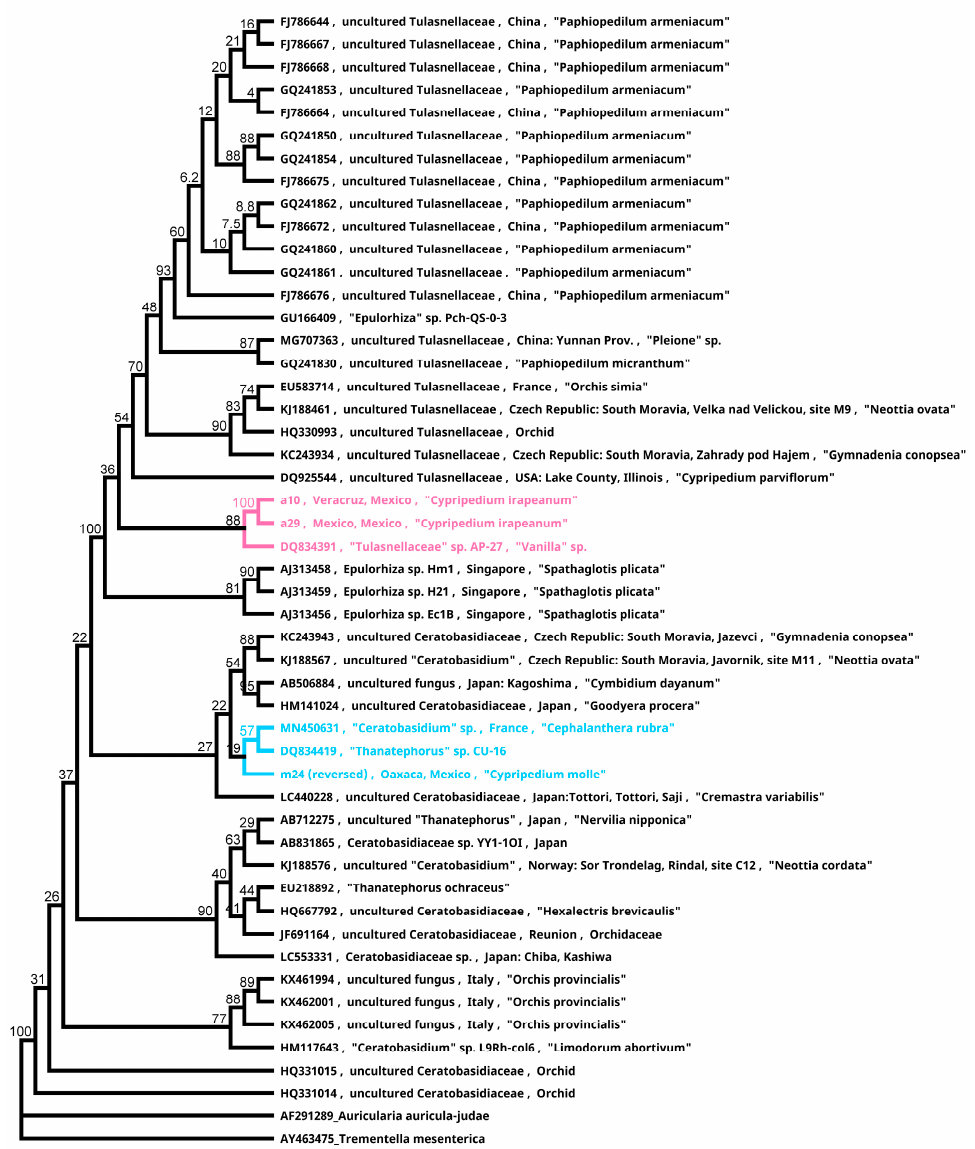
Figure 9. Phylogenetic relationships of endophytes isolated from Mesoamerican Cypripedium . The pink clade represents isolates from Cypripedium irapeanum from a tropical dry forest and Quercus forest. The blue clade contains the isolate from C. molle , which was inferred by using the maximum likelihood method and the Tamura-Nei model log likelihood of –3241.26. The branch length labels represent the bootstrap proportions. Analyses were conducted in Geneious (2021.0.3).